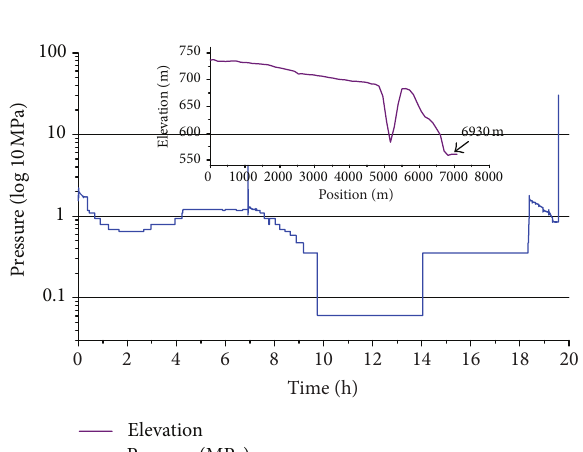
when the liquid level quickly dropped. On the contrary, the flow rate of top was much larger than that at the outlet when the liquid level quickly rose. The simulated time of the first pigging operation was 19.6 hours. During this period of time, the maximum pressure of compressed air was as much as 1.03 MPa as shown in Figure 7. Finally, the gas cavity collapsed resulting in an impulse pressure up to 37.03 MPa as shown in Figure 6. The value of the impulse pressure is also larger than the bursting pressure of the tube, and the second accident occurred as shown in Table